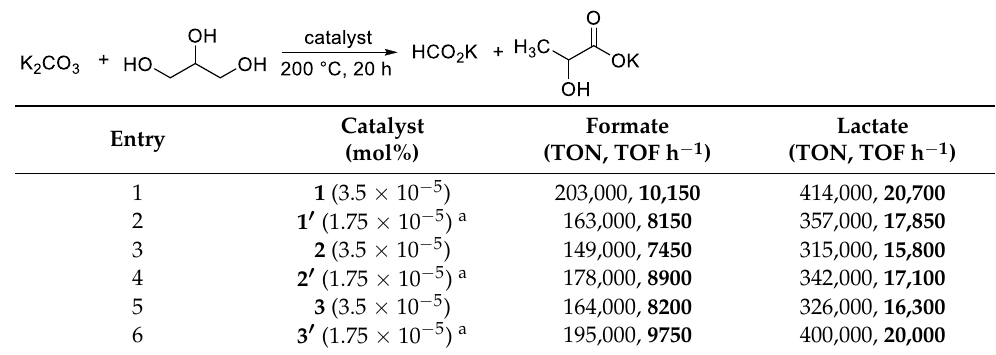
Table 2. Transfer hydrogenation of K 2 CO 3 in glycerol.